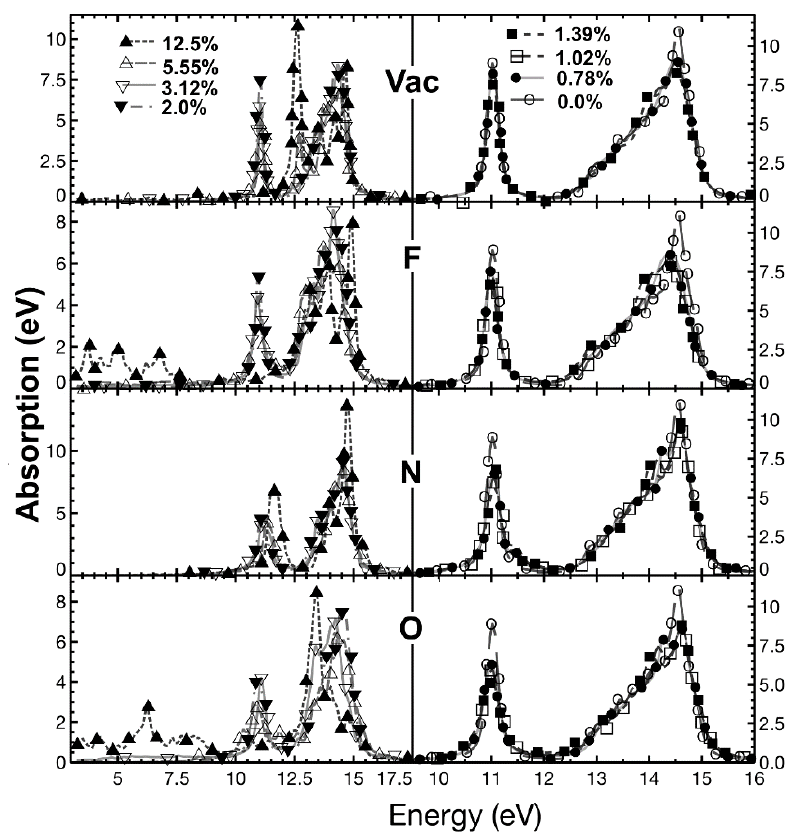
Figure 17. We present the absorption in the ultraviolet region for different dopant (or vacancy) concentrations. For 0% (pristine graphene): O; for 0.78%: • ; for 1.02%: (cid:3) ; for 1.39%: (cid:4) ; For 2.0%: (cid:72) ; for 3.12%: (cid:53) ; for 5.55%: (cid:52) ; for 12.5%: (cid:78) . At the top, we have the absorption for different vacancy concentrations. At the bottom, we have the optical absorption for different oxygen percentages. As in the two previous cases, we show the absorption for fluorine and nitrogen for the same concentration variation in the middle. The horizontal axis marks the energy of incident electromagnetic radiation.